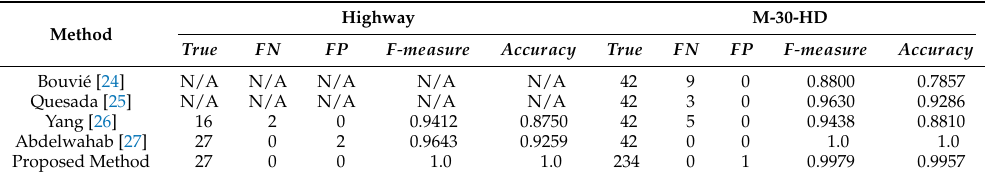
Table 10. The comparison of experimental results with existing state-of-the-art